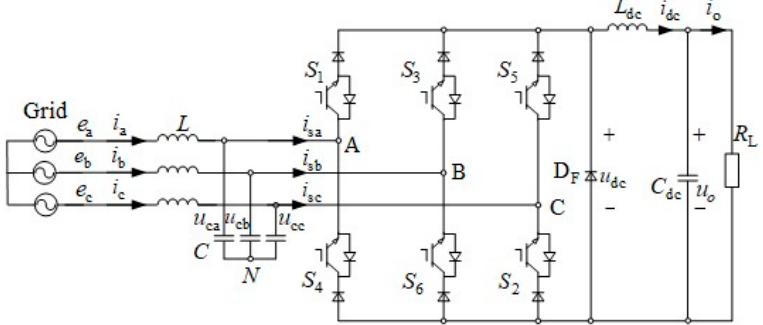
Figure 1. Topology of three-phase current source converter